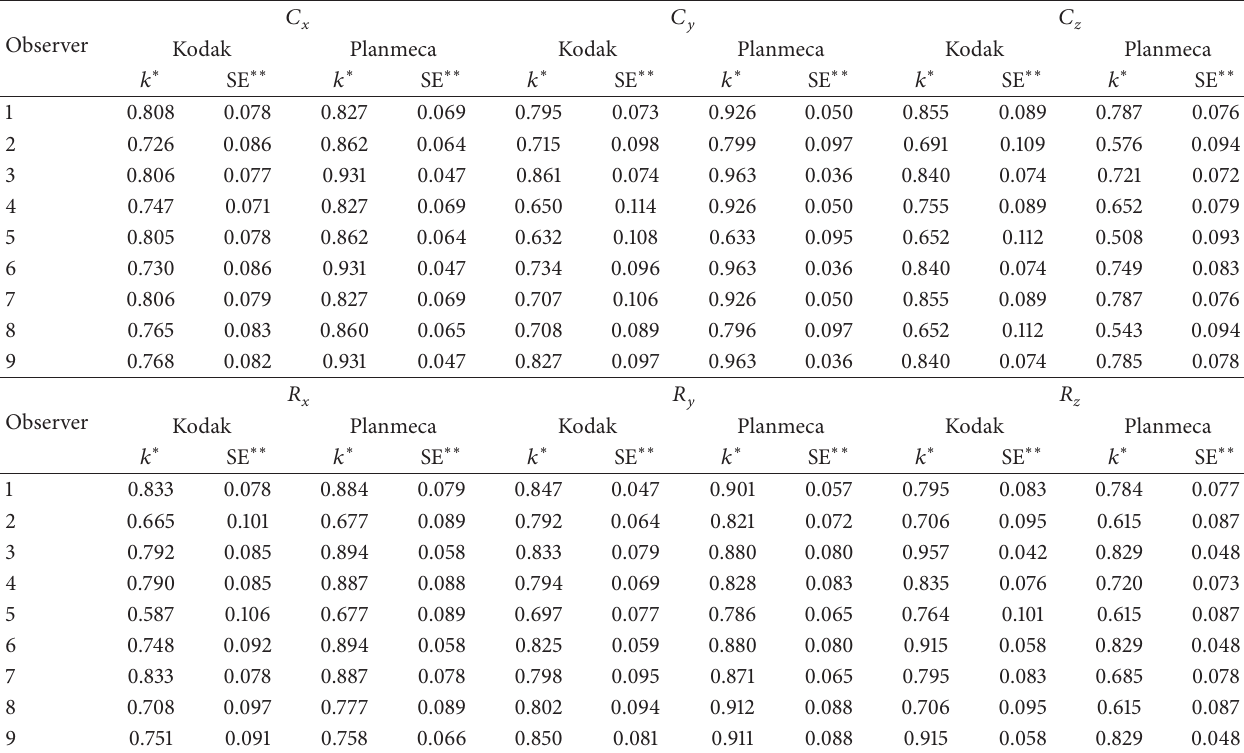
Table 5: Kappa coefficients for intrarater agreement between 𝑡 2 and 𝑡 3 , clustered by software and KPG single component.